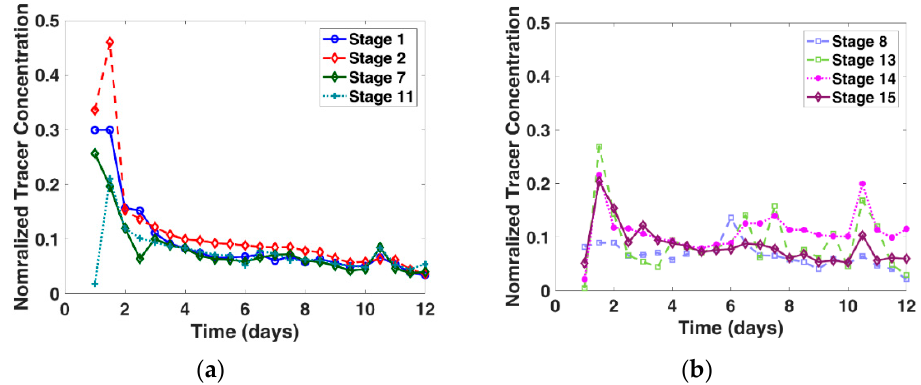
Figure 17. Tracer response curve divided into two categories. Plot ( a ) shows stages having a single early peak. Plot ( b ) shows stages having multiple peaks.